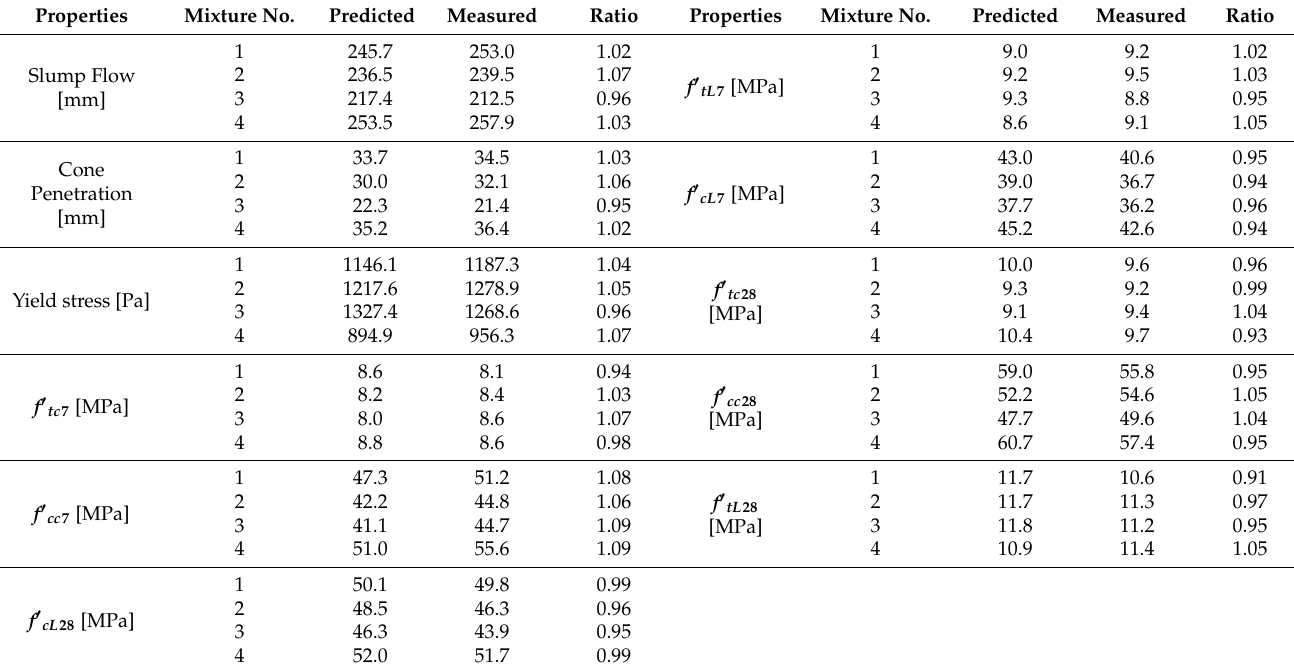
Table 8. Ratio of predicted-to-measured